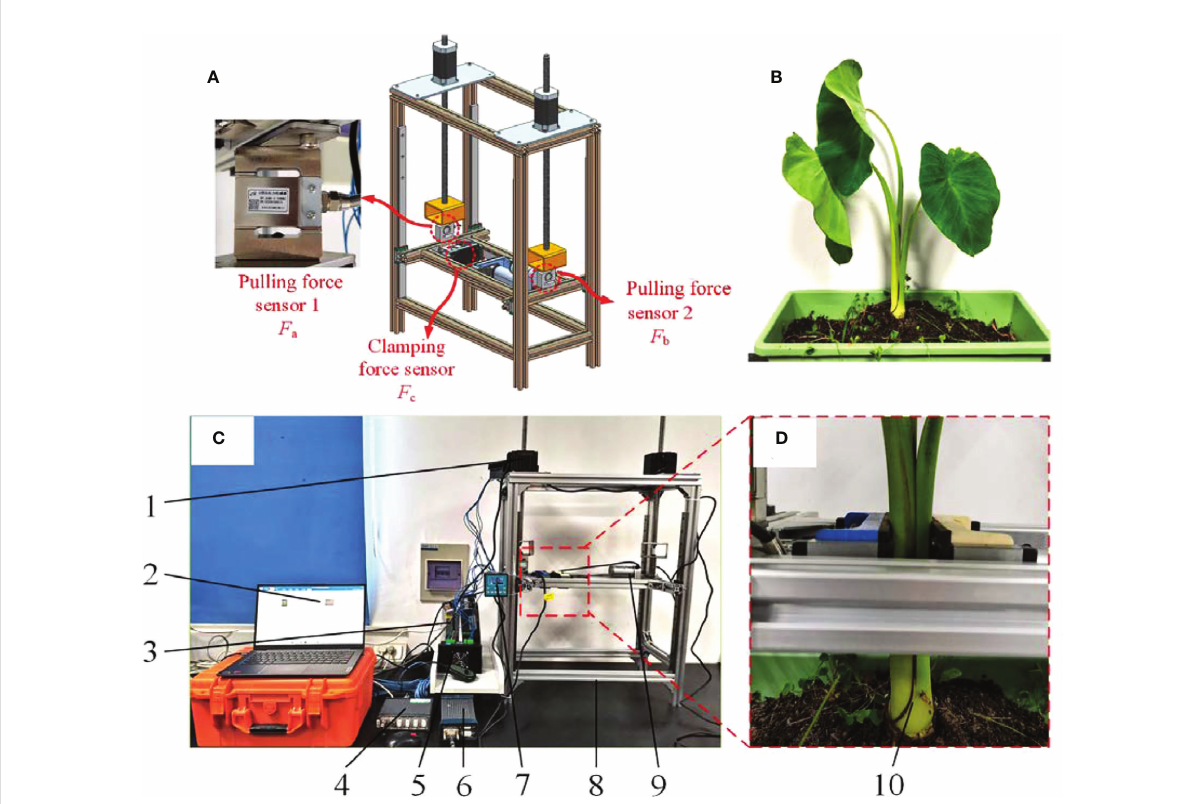
FIGURE 5 Mechanical force measuring platform of clamping and pulling device. (A) Sensor installation location; (B) Taro plant; (C) Mechanical force measuring platform of clamping and pulling device; 1. 86 stepper motor 2. PC test software 3. 48V power supply 4. DH380 controller 5. Motor driver 6. DH3820 collector 7. 86-stepper motor controller 8. Clamping force measuring platform 9. Electric pusher petiole 10. Taro Plant. (D) Clamping position of taro